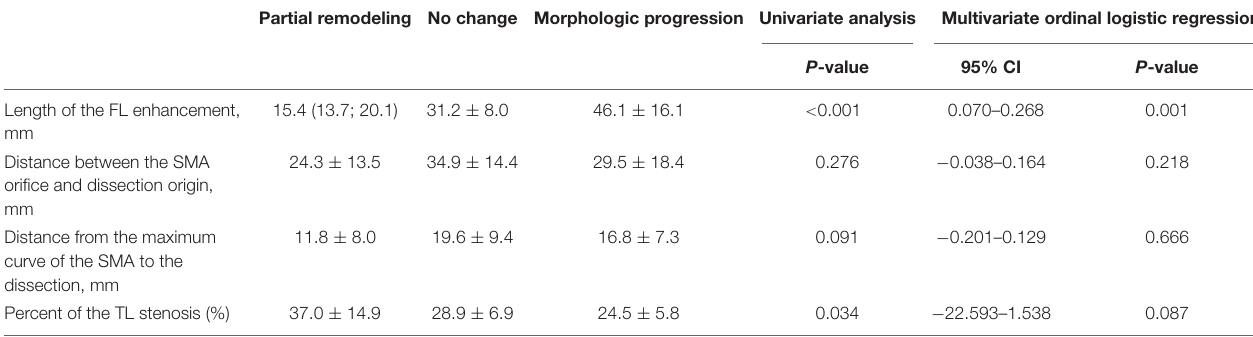
TABLE 3 | Determinant affecting morphological progression in Type II SISMAD with “cul-de-sac” shaped FL without re-entry. Partial remodeling No change Morphologic progression Univariate analysis Multivariate ordinal logistic regression